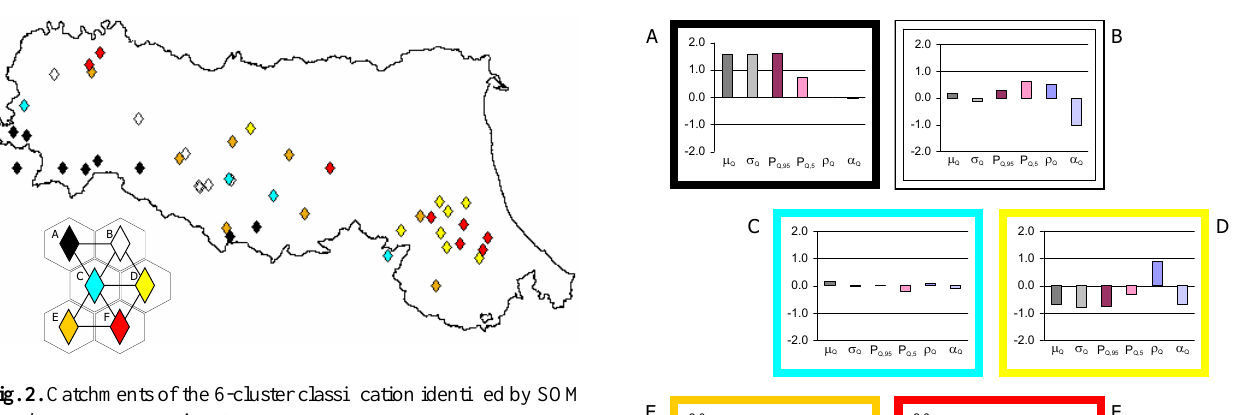
Fig. 2. Catchments of the 6-cluster classification identified by SOM based on streamflow signatures.